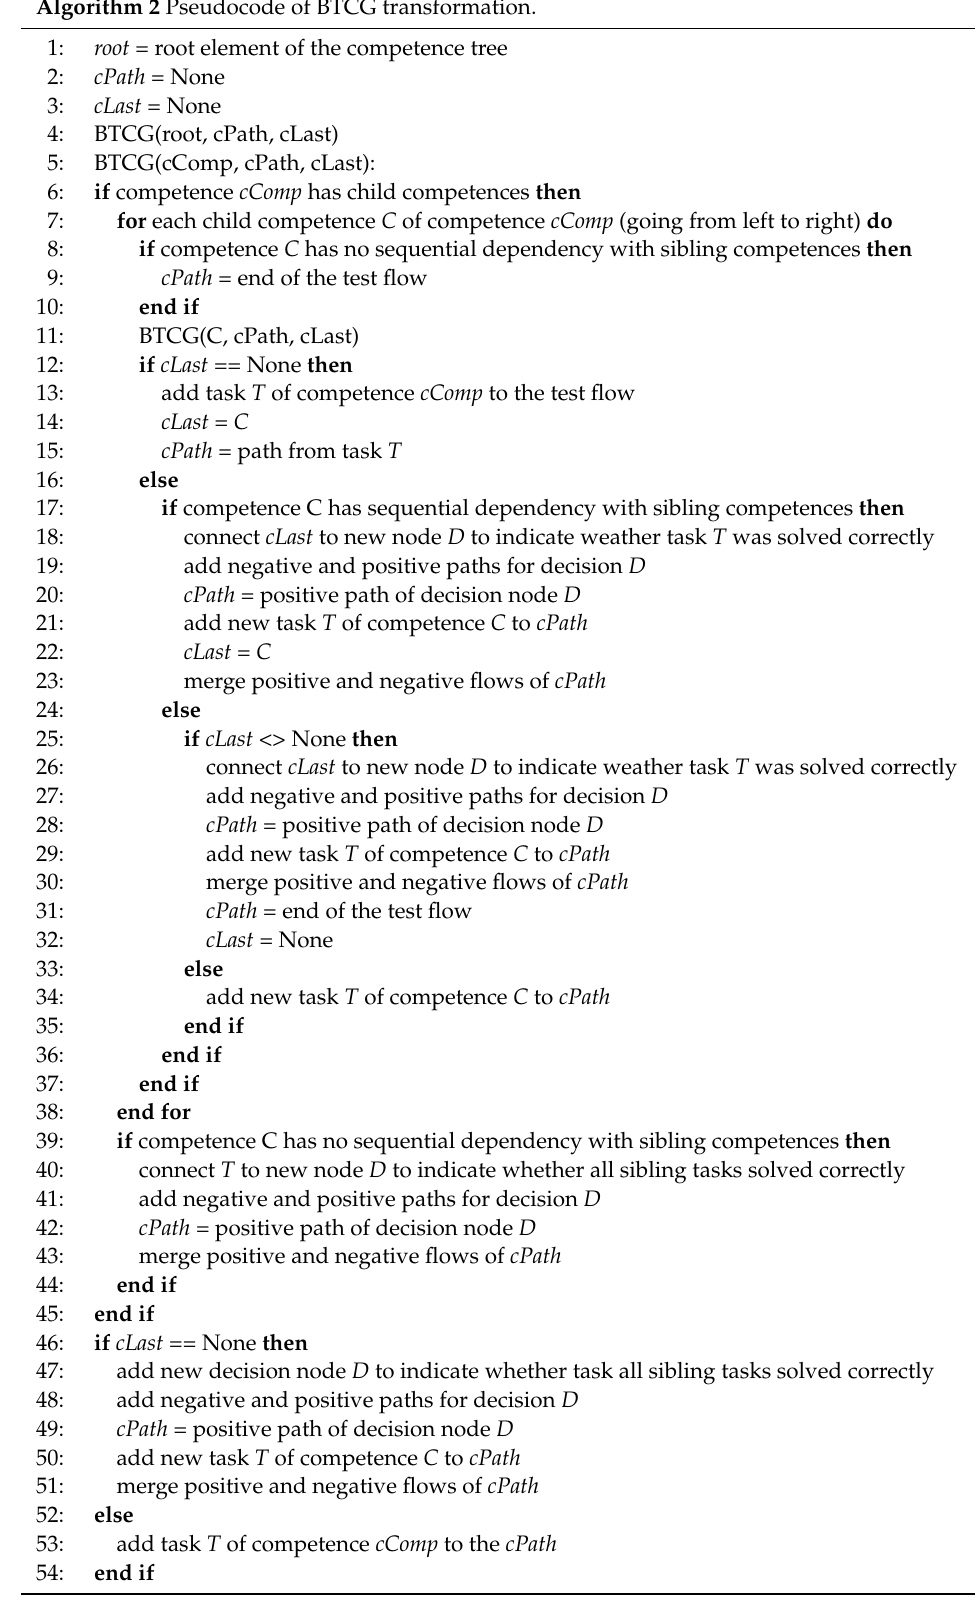
Algorithm 2 Pseudocode of BTCG